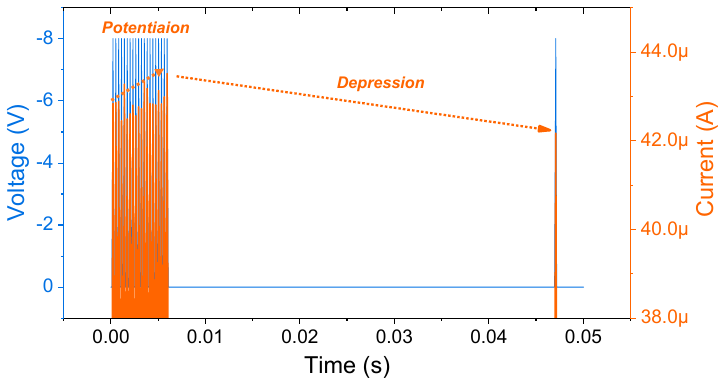
Figure 7. Potentiation and depression characteristics caused by controlling pulse interval time in the TiN/TiO 2 (6 nm)/WO x /Pt device.